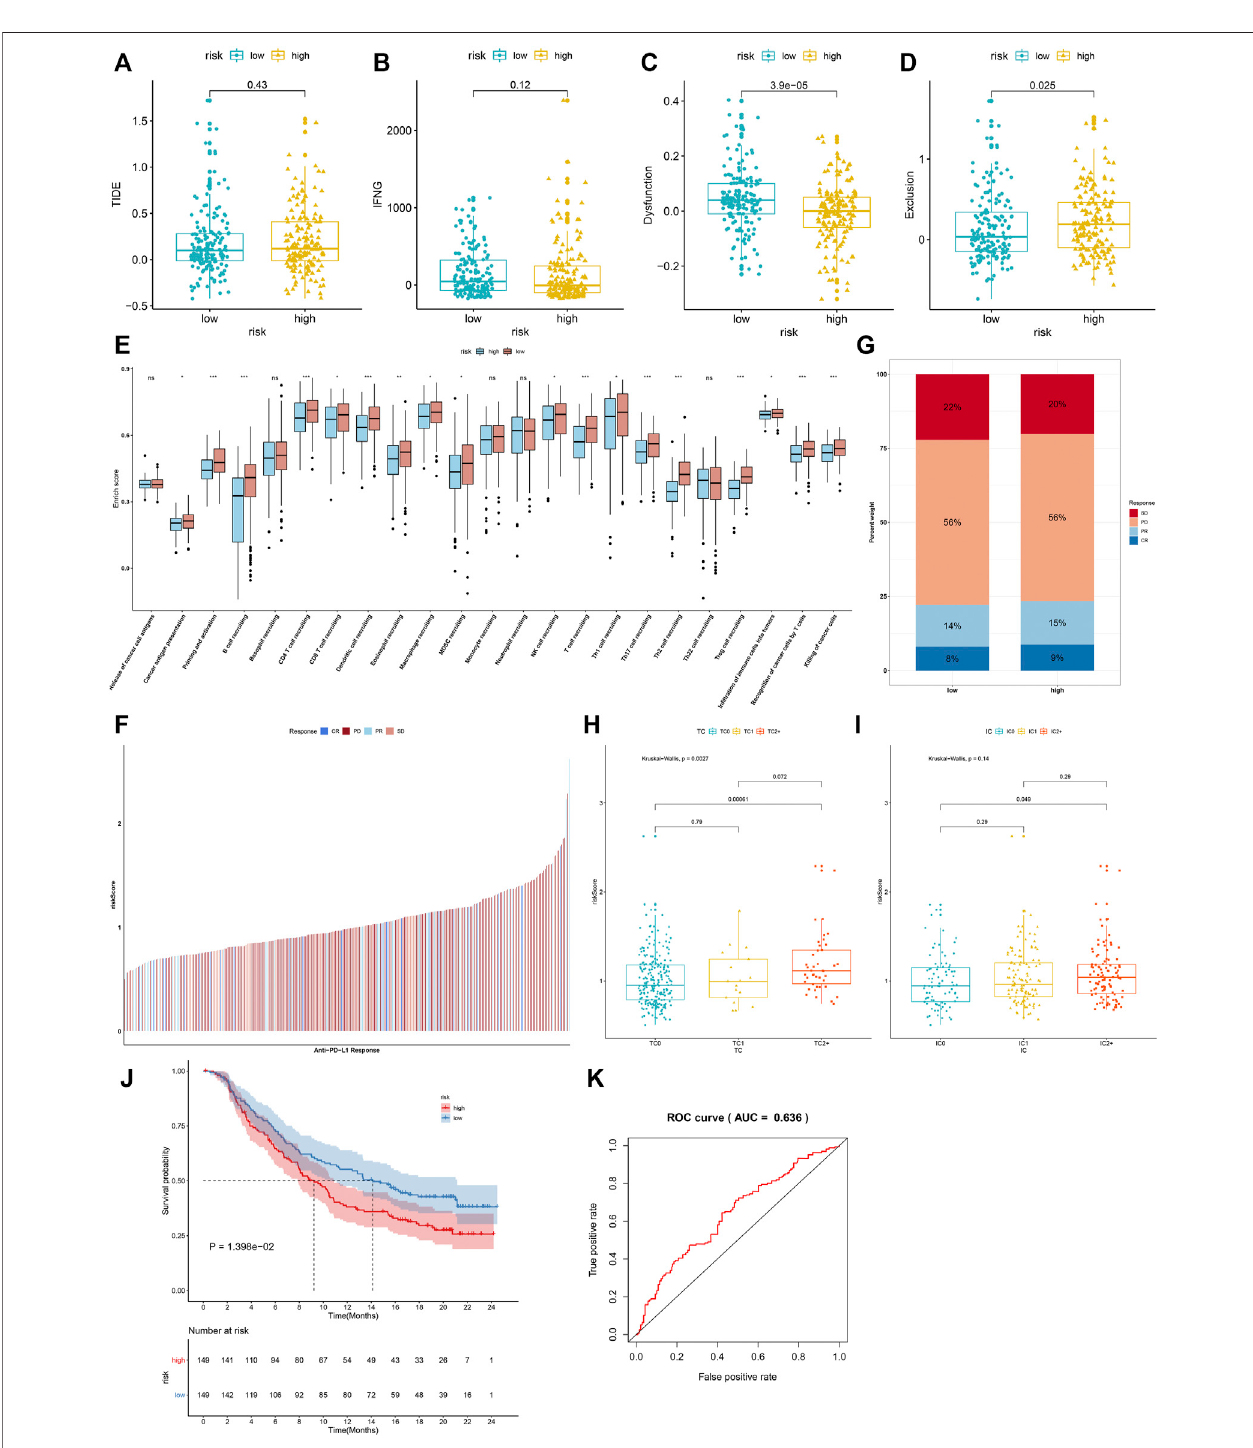
FIGURE8| IRSpredictsimmunotherapeuticresponse. (A – D) ComparisonsofTIDEscore,T-cellreceptorinterferon-gamma(IFN-G),T-celldysfunction,andT-cell exclusioninhigh-and low-riskgroups. (E) Differencesineach stepofthecancerimmunitycycleinhigh- andlow-riskgroups. (F) DistributionofIRSamongpatientswho haddifferentresponses(CR,completeresponse;PR,partialresponse;PD,progressivedisease; SD,stabledisease)toanti-PD-L1therapyintheIMvigor210cohort. (G) Percentageofdifferentresponsestoanti-PD-L1therapyinhigh-andlow-riskgroups. (H) ComparisonsofIRSindiversetumorcellpopulations. (I) Comparisonsof IRS in diverse tumor cell types. (J) The K – M survival curves between high- and low-risk patients treated with anti-PD-L1 therapy. (K) ROC curves of survival based on IRS. Ns: not signi fi cant; * p < 0.05; ** p < 0.01; and *** p < 0.001.